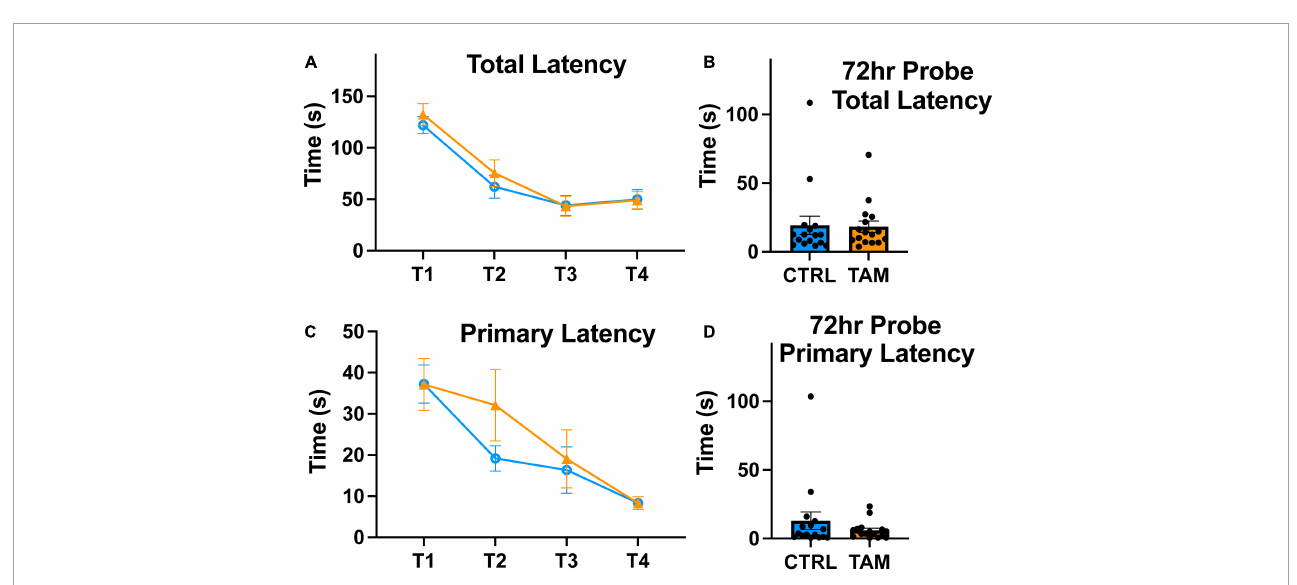
FIGURE4 Tamoxifen treatment does not impair spatial learning. Blue lines and bars show results from control mice (CTRL); orange lines and bars show tamoxifen-treated mice (TAM). (A) Average latency to full entry into the escape hole of the four trials completed by each mouse across 4 training days (T1-T4). (B) Time in seconds to escape from Barnes Maze on probe trial conducted 72 h following the T4. (C) Average latency to first approach to escape hole of the four trials completed by each mouse from T1-T4. (D) Time in seconds until the first approach to escape hole on probe trial conducted 72 h following the final training trial. N = 16 mice per group; mean ± standard